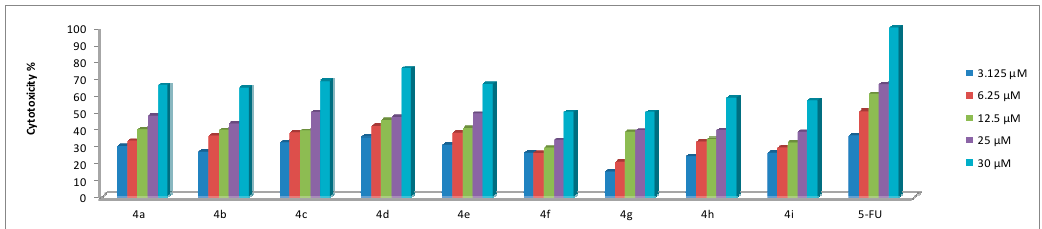
Figure 5. Dose dependent cytotoxic activities of new compounds on MDA-MB-231 cancer cells according to the MTT assay.